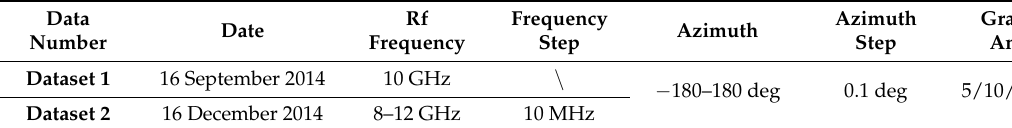
Table 2. The condition setting of backscatter coefficient measurement.